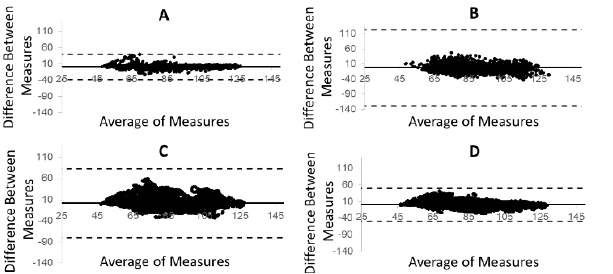
Figure 4. Bland – Altman plots of heart rate (bpm) during lifestyle activity for the ( A ) Apple Watch series 4, ( B ) Garmin Forerunner 735XT, ( C ) Jabra Elite earbuds, and ( D ) Scosche Rhythm 24 devices compared to the Polar H7. Dashed lines represent 95% limits of agreement.